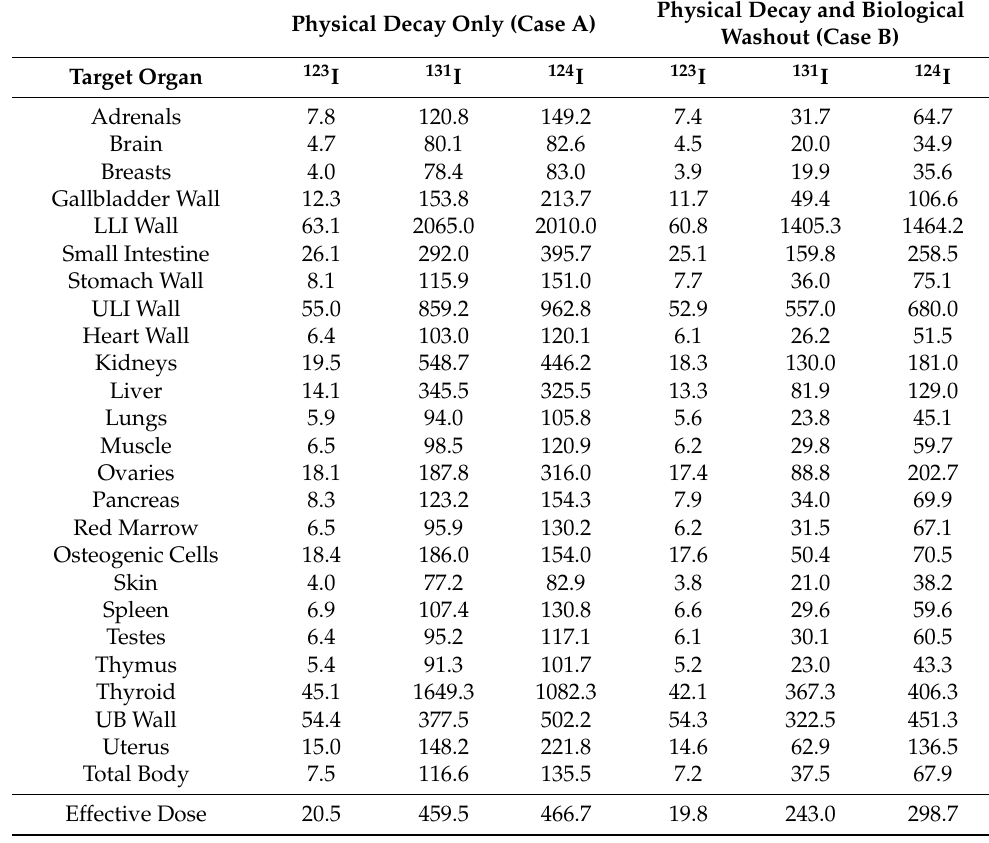
Table 4. Equivalent doses in µ